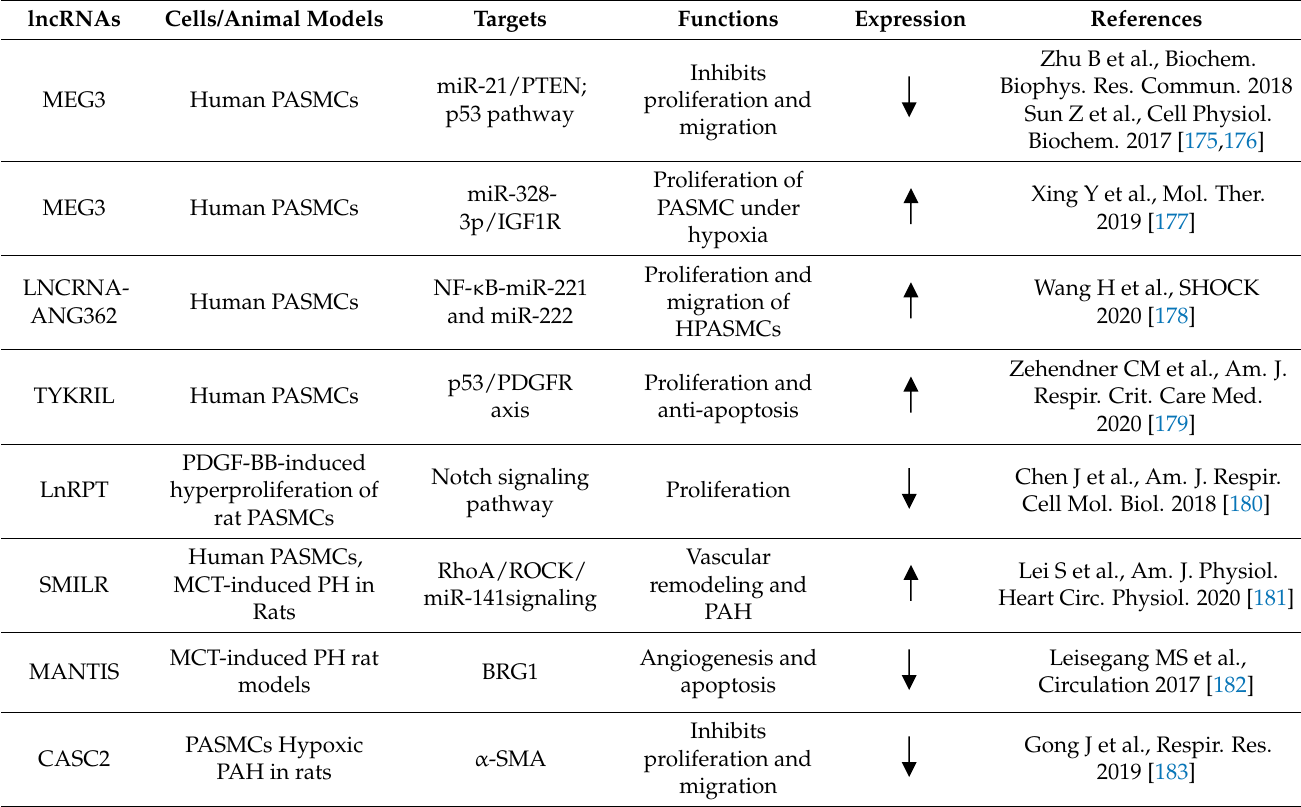
Table 3. Summary of important lncRNAs involved in PAH pathogenesis.